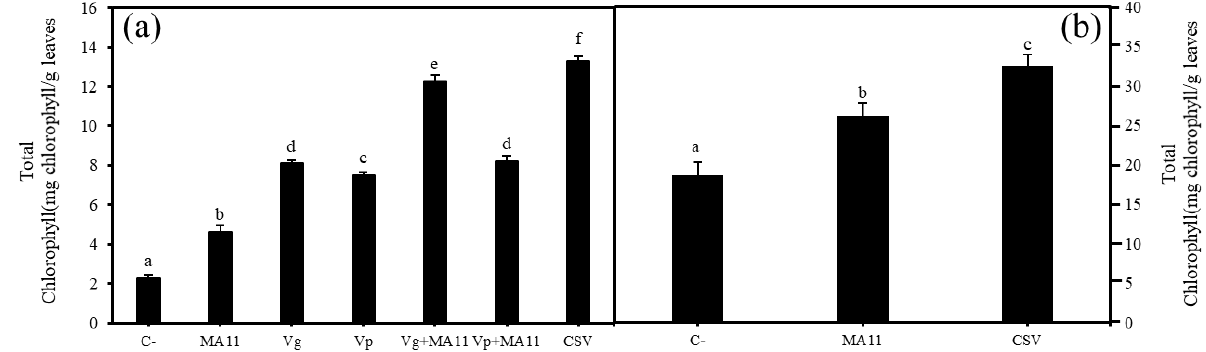
Figure 5. Total chlorophyll content. ( a ) The total chlorophyll content in leaves of M. sativa after 60 days under greenhouse conditions with a nutrient-poor soil as a substrate; ( b ) total chlorophyll content in leaves of M. sativa after 60 days under greenhouse conditions with soils polluted with metals. Values are means ± S.D. ( n = 16). Different letters indicate means that are significantly different from each other (one-way ANOVA; LSD test, p < 0.0001). C-: non inoculation; MA11: inoculation with E.